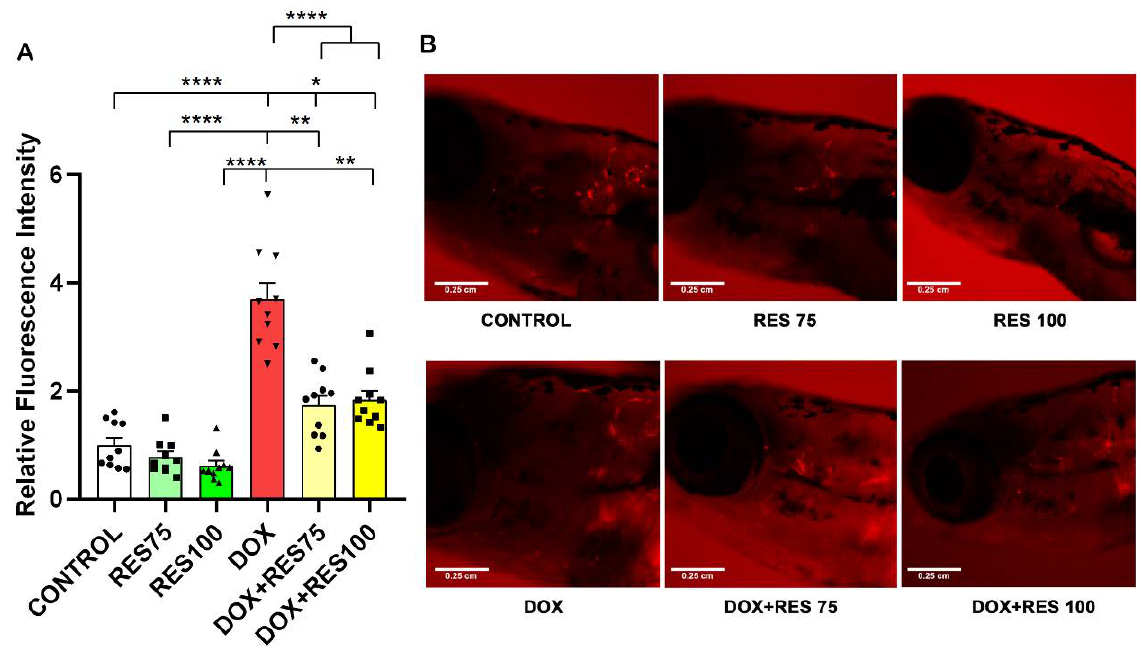
Figure 7. Inhibitory effect of resveratrol on doxorubicin-induced stimulation of osteoclasts. The ctsk reporter zebrafish transgenic line ( Tg[ctsk:DsRed ]) at 25 dpf was exposed to different concentrations of resveratrol (RES, 75 µ M and 100 µ M) alone or together with Doxorubicin (DOX, 17.2 µ M) for 96 h and ctsk signal was measured in the head area. Quantification of fluorescence intensity between the treatment groups performed using fluorescent images acquired with the same parameters and analyzed with ImageJ ( A ), and ctsk -positive cells in the head of fish from the different treatment groups ( B ). One-way ANOVA, Tukey’s multiple comparisons test, *— p ≤ 0.05, **— p ≤ 0.01, ****— p ≤ 0.0001.